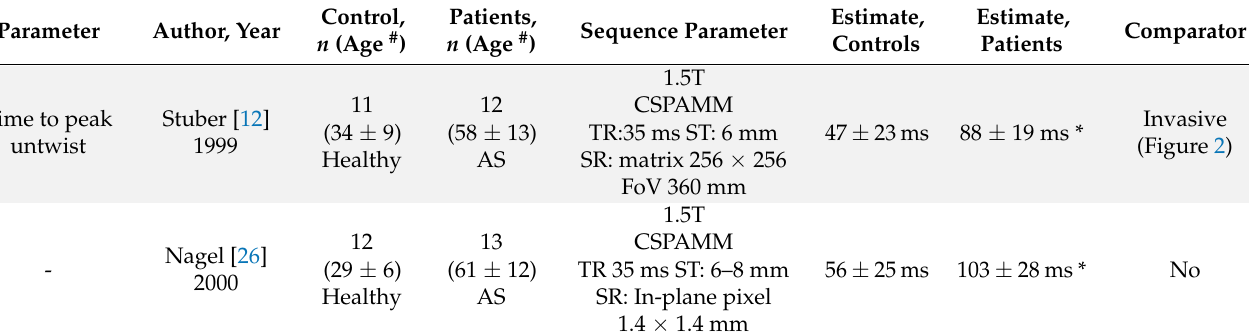
Table 3. CMR tagging—time to peak untwisting